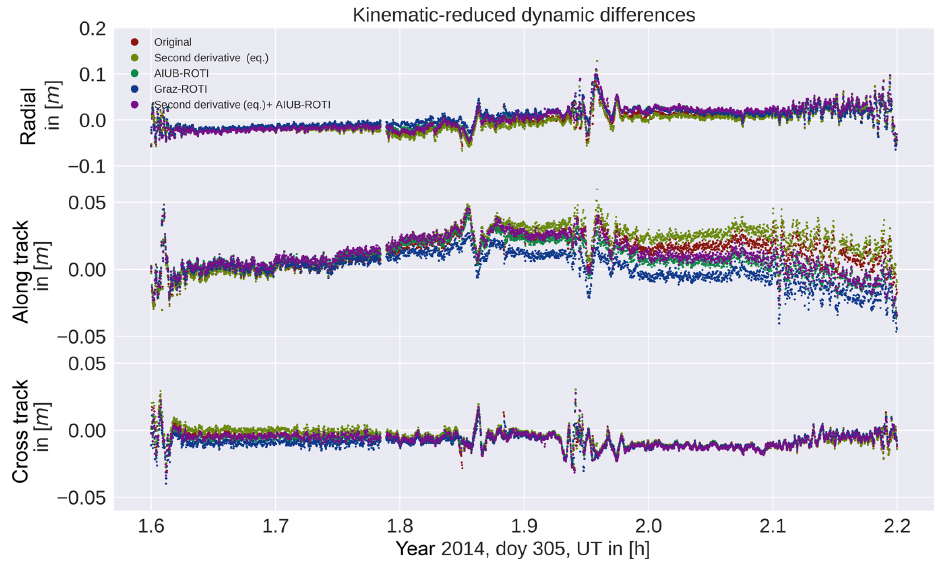
Figure 11. Kinematic minus reduced-dynamic positions in radial, along-track, and cross-track directions. For both kinematic and reduced- dynamic positions, the same weighting was applied.